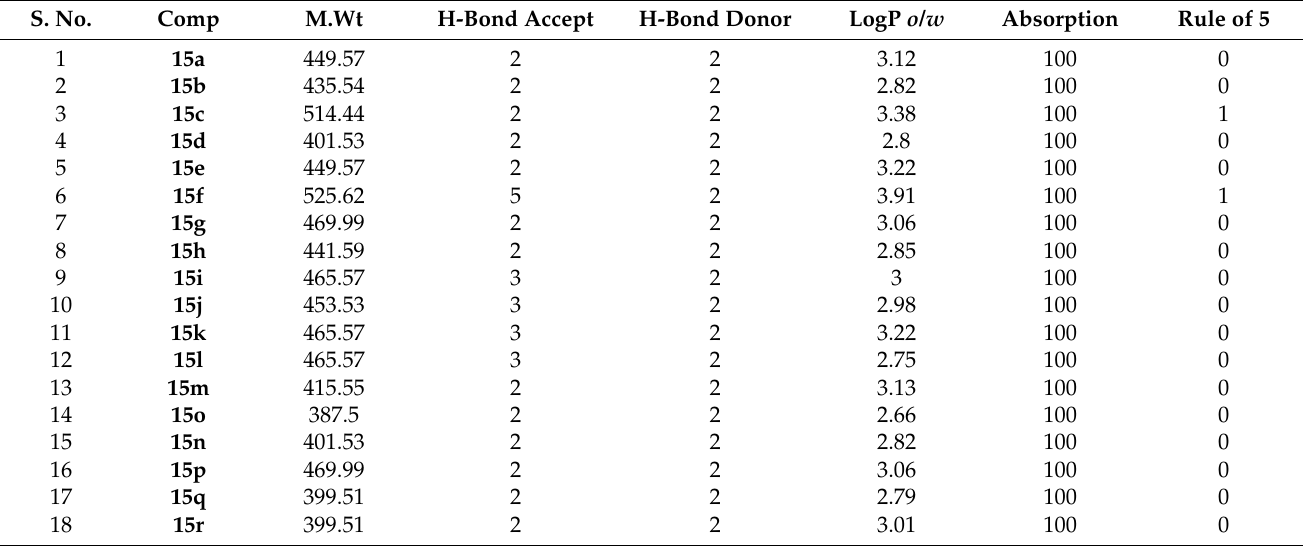
Table 3. ADME profiles for all synthesised compounds ( 15a–r